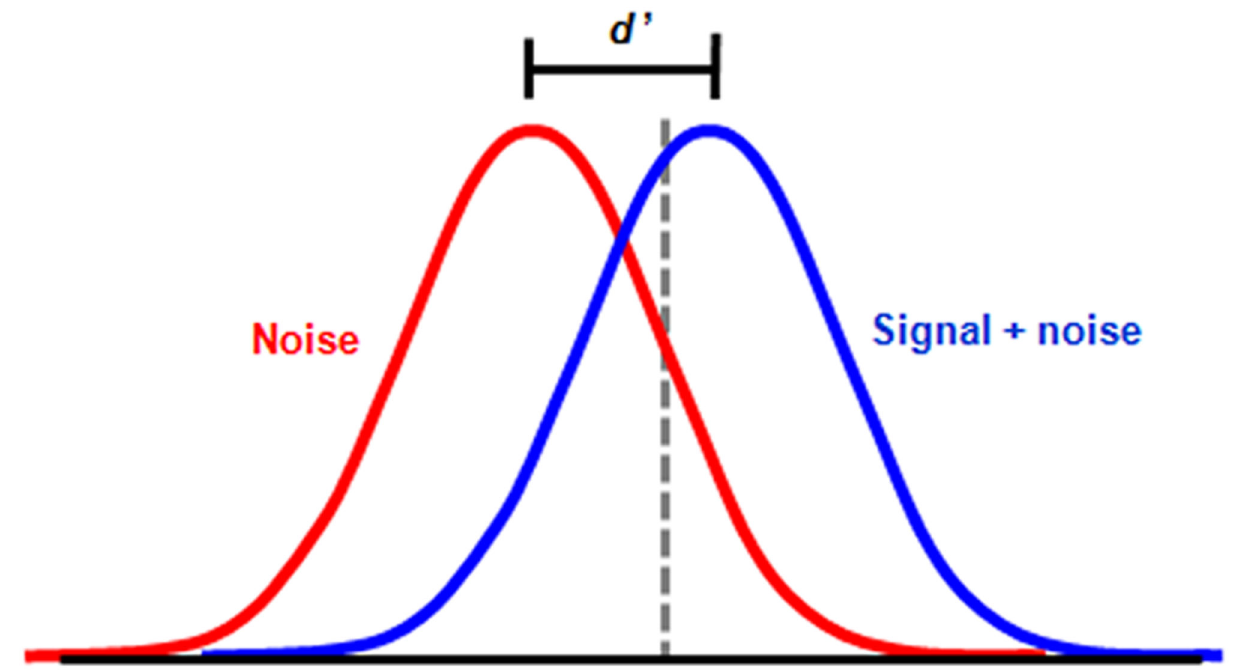
Figure 1. Signal Detection Theory. Normal distributions representing the internal neural activity associated with noise (no stimulus) and signal-plus-noise (stimulus). True sensitivity to the stimulus is denoted d'. The response criterion is represented by the dotted line and reflects the subjective level at which noise is distinguished from signal. In this example, the subject uses a high criterion and is more inclined to say “no” to stimulus presentation than to say